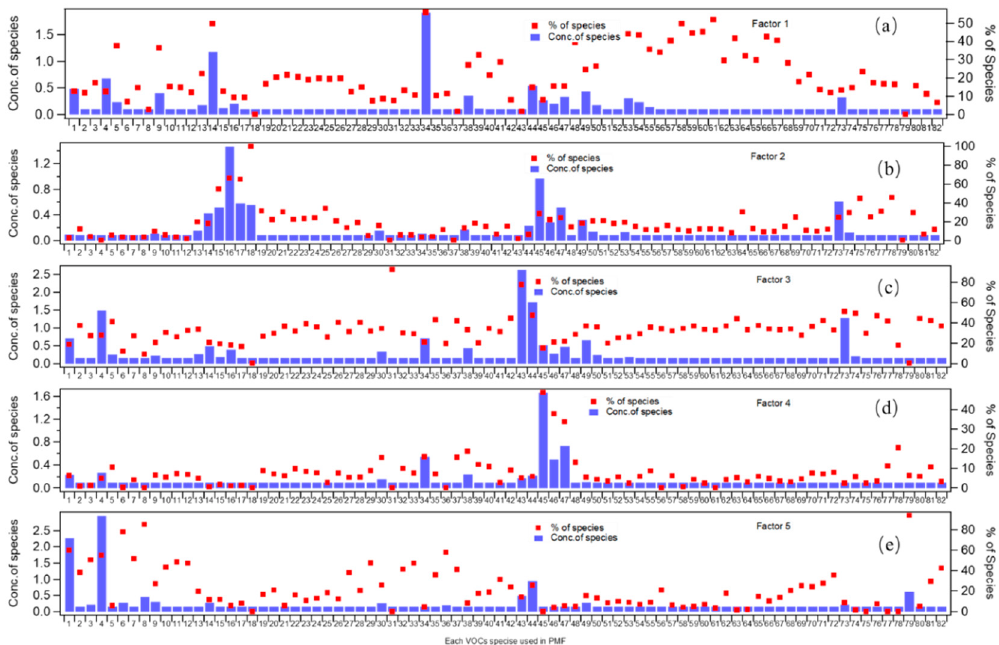
Figure 8. Source profiles of VOCs identified using the positive matrix factorization (PMF) receptor model and the relative contributions of the individual VOC species (from the SL site before control). ( a – e ) represent the characteristics of each source factor (Factor 1-Factor6). The name of each VOC species is listed in Table